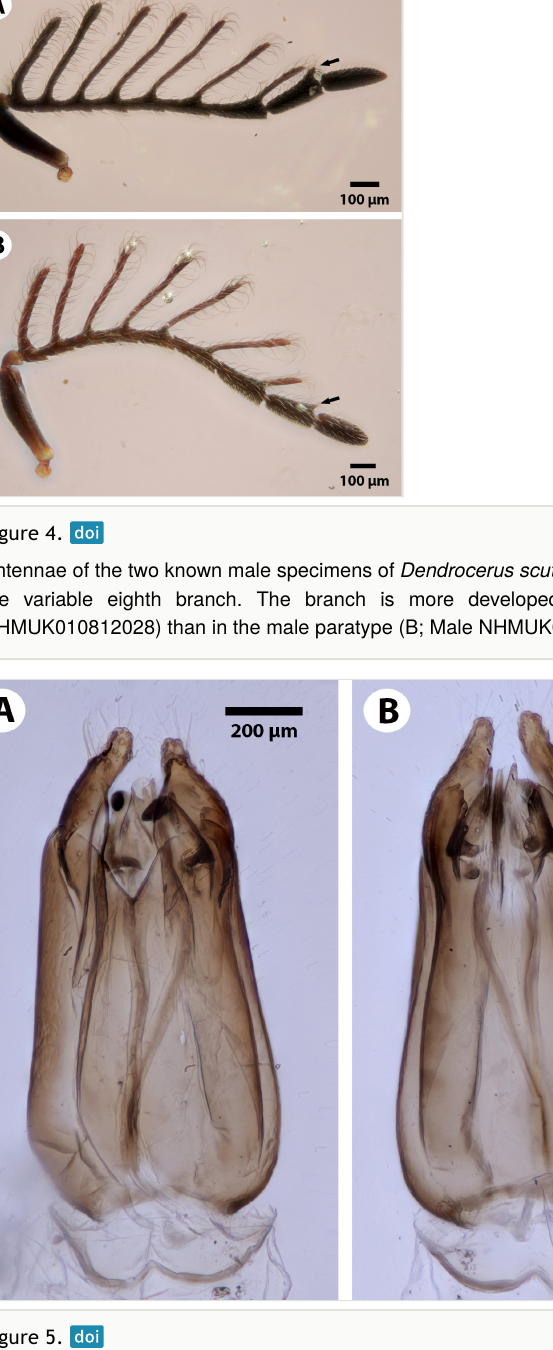
Figure 5. Genitalia of the male holotype (NHMUK010812028). A. Dorsal view. B. Ventral